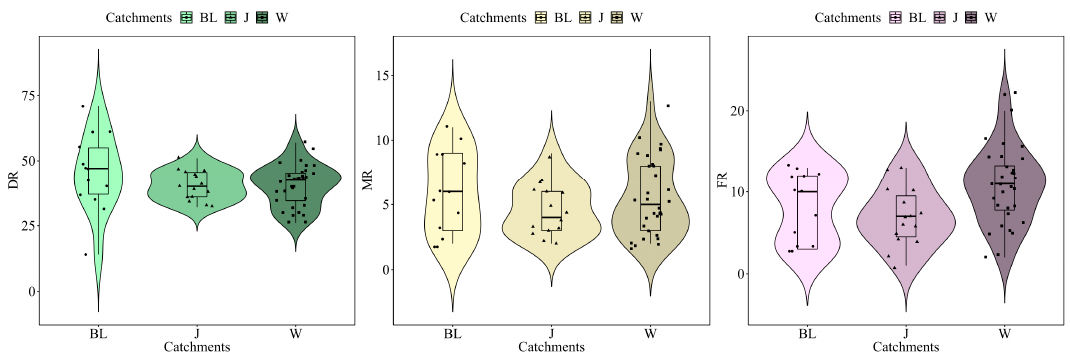
Figure 7. Distribution of three biotic indicators of diatom, macroinvertebrate and fish assemblages at each catchment in the Wei River basin. DR: diatom richness, MR: macroinvertebrate richness, FR: fish richness.